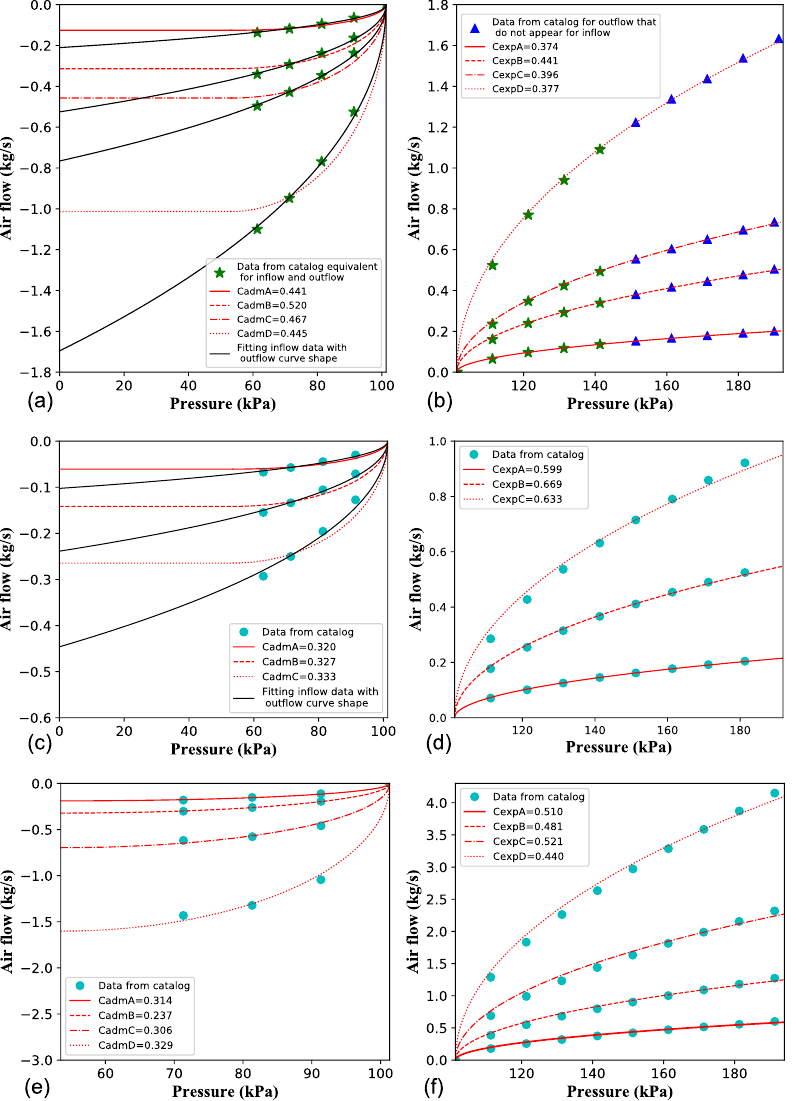
Figure 1. Typical CCs of air valves found in product catalogs: ( a , b ) with CCs for which the graphs for admission and expulsion are actually equivalent despite being presented separately; ( c , d ) with CCs for which the graphs for admission are only consistent with the shape of the isentropic outflow model, while the graphs for expulsion are consistent with the isentropic outflow model; ( e , f ) with CCs for which the graphs for admission are consistent with the inflow model, and the graphs for expulsion are consistent with the outflow